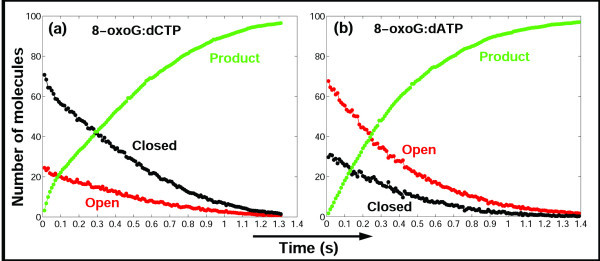
Simulation results based on the network models. The mean trajectories of the match (a) and mismatch (b) 8-oxoG systems obtained from 100 independent simulations with STOCKS [36]. The red, black, and green curves describe the evolution of the open, closed, and chemical product species, respectively.